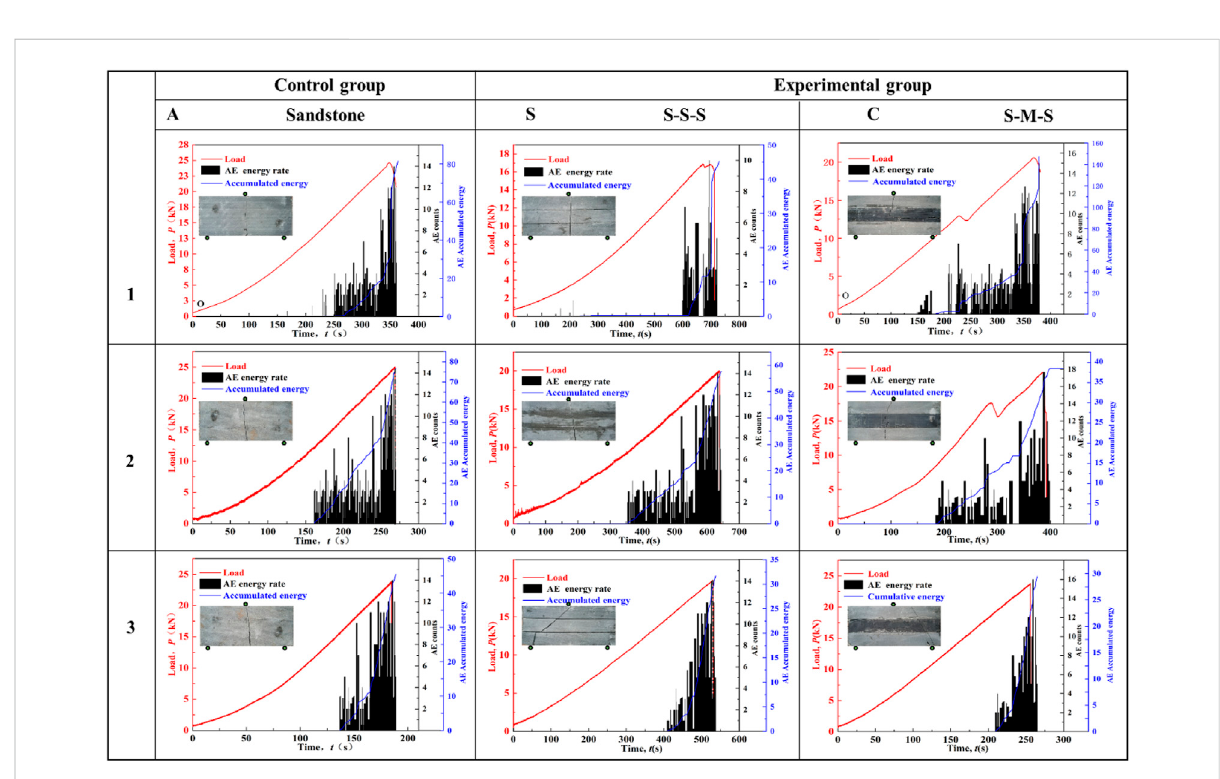
FIGURE 4 Variation of load and AE energy with